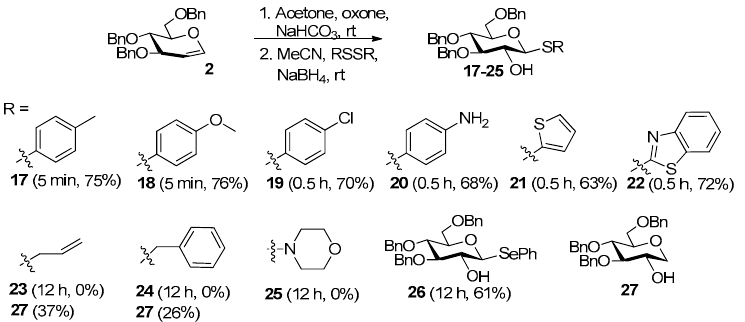
Figure 5. Evaluation of reactions between various disulfides and glucal 2.